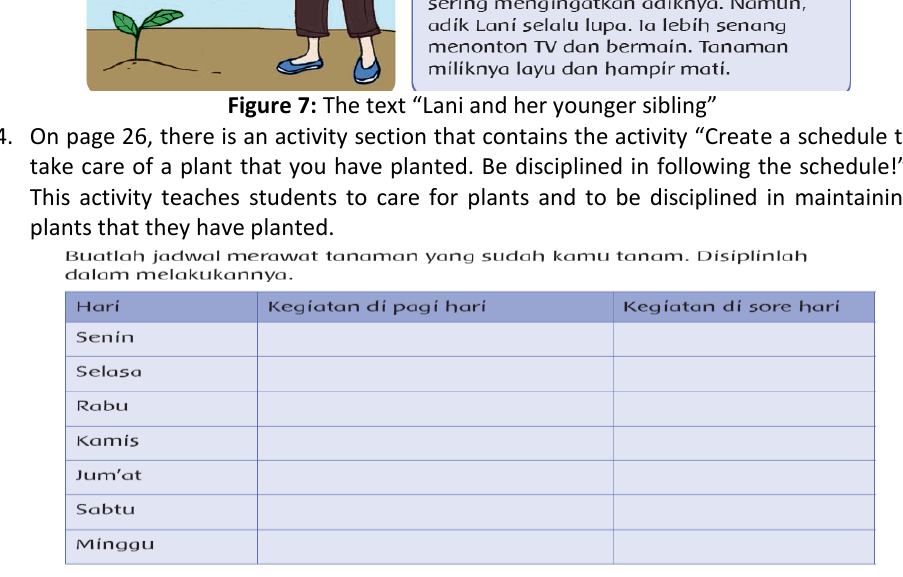
Figure 8: Schedule for Maintaining your